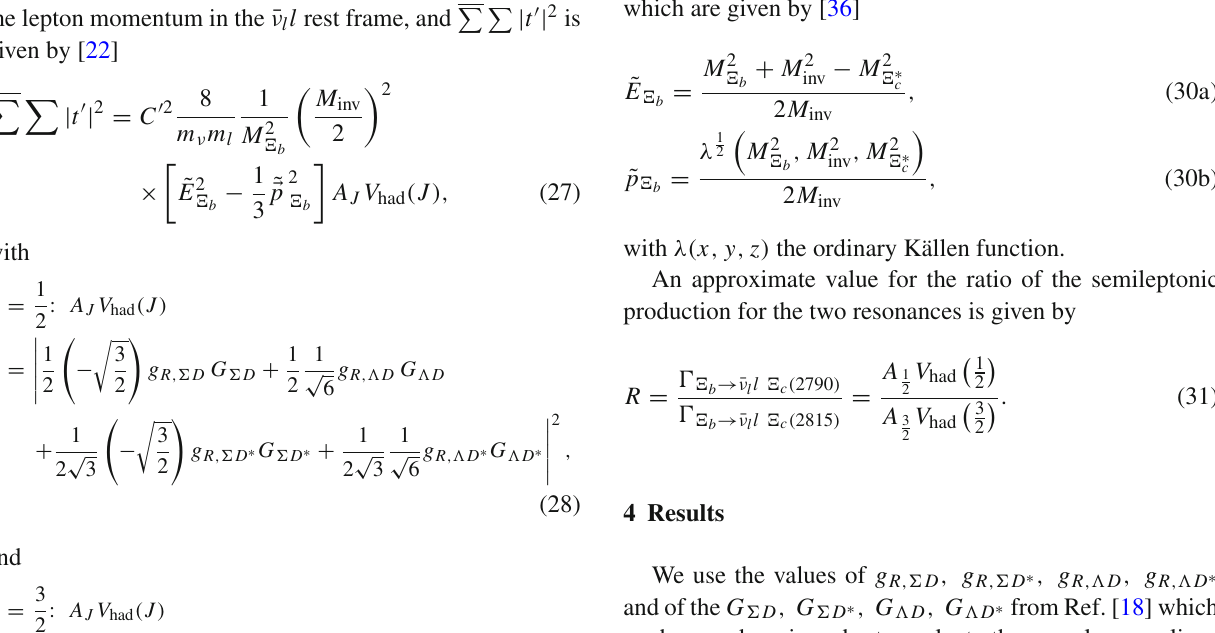
→ ¯ ν (cid:2) ( 2815 ) decay is very similar b l l c